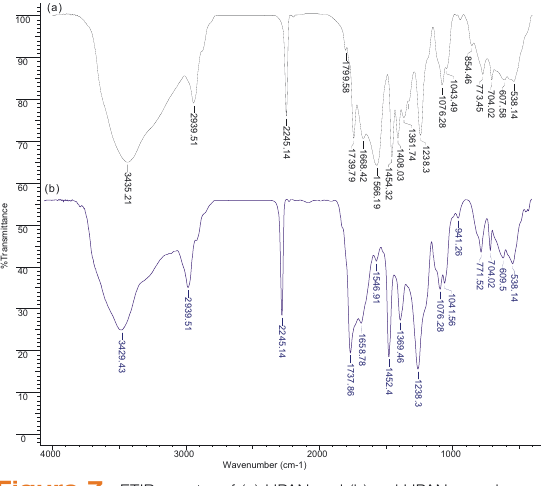
Figure 7. FTIR spectra of (a) HPAN and (b) red HPAN samples.